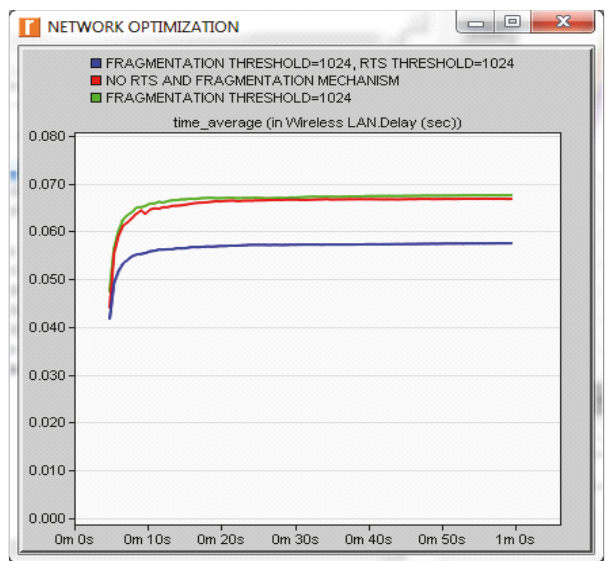
Figure 20: WLAN retransmission attempts optimization with RTS and fragmentation mechanisms.